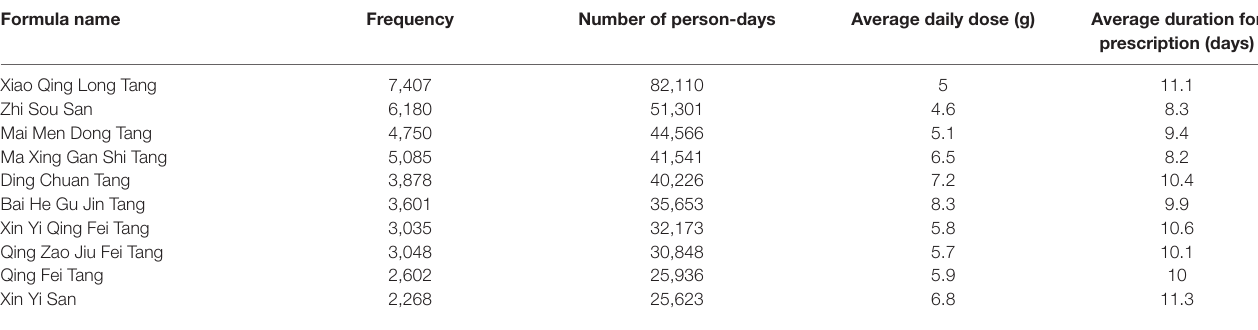
TABLE 4 | Ten most common formulas prescribed for patients with